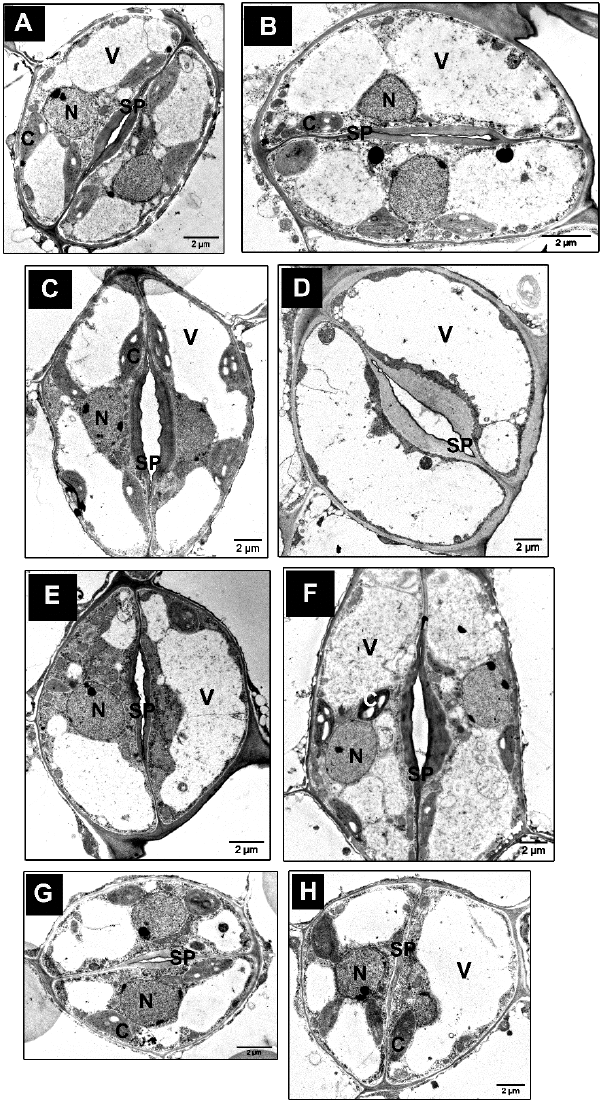
Figure 5. TEM of stomata and GCs from rosette leaves of WT, tgg1 , tgg2 single and tgg1 tgg2 double mutants of Arabidopsis . ( A , B ). WT: GCs showing chloroplasts, open stomatal pore, nuclei, and small to big vacuoles in GCs. ( C , D ). tgg1 single mutant: Showing vacuoles with less electron-dense material and open stomatal pores, ( E , F ). tgg2 single mutant: ( E ). Stoma with slightly open stomatal pore, nucleus, with both small and big vacuoles, and chloroplasts with more prominent starch grains. ( F ). A bigger stoma with open stomatal pore; showing chloroplasts, nuclei, and big vacuoles in GCs with electron-dense granular material. ( G , H ). tgg1 tgg2 double mutant: Small sized stomata showing vacuoles with less electron-dense material, chloroplasts, nuclei. C = chloroplast, M = mitochondria, N = nucleus, SP = stomatal pore, and V = vacuole. (Bars = 2 µ